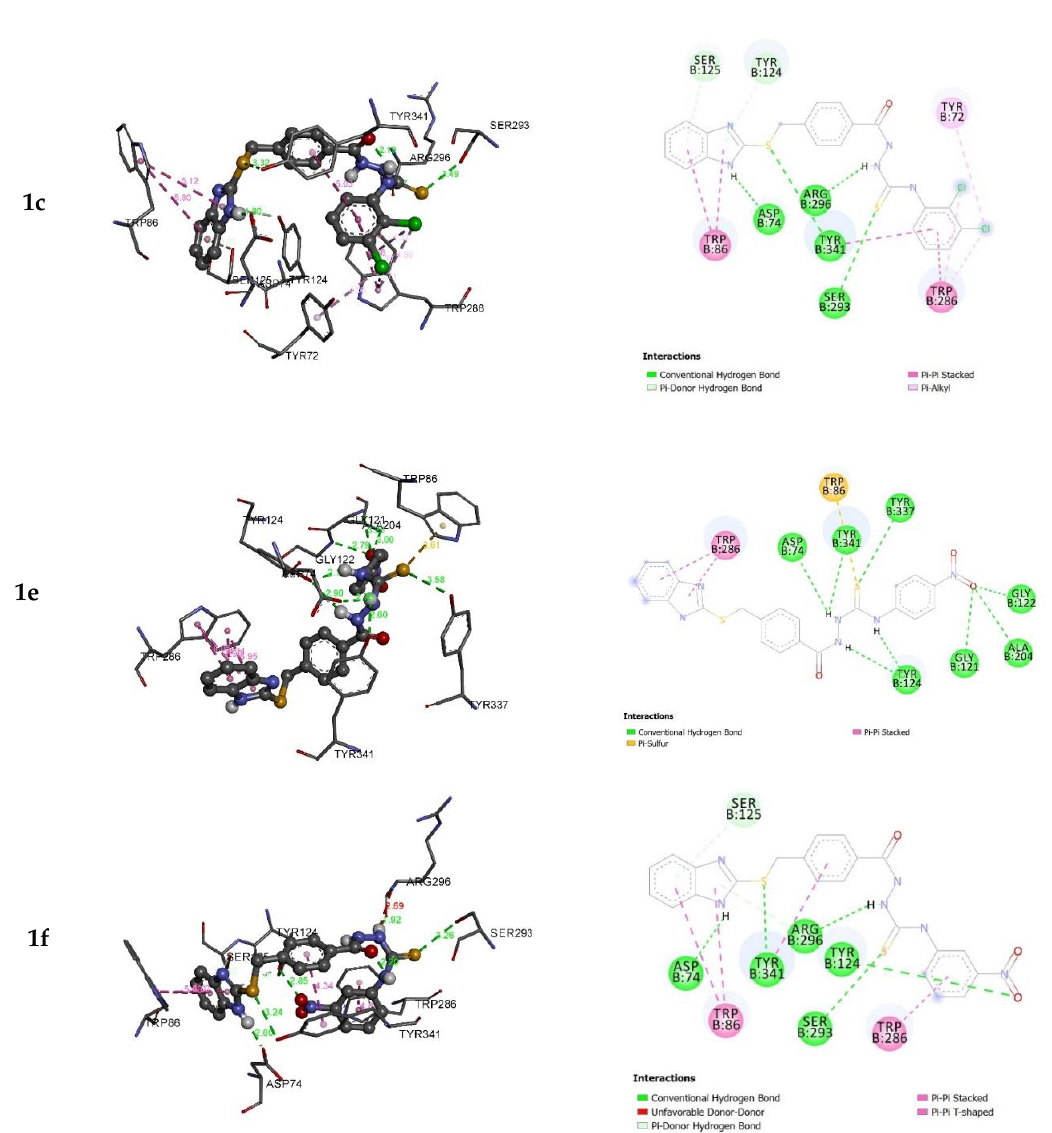
Figure 3. Three-dimensional ( right ) and two-dimensional ( left ) closest interactions between the active site residues of acetylcholinesterase and benzimidazole thiosemicarbazide derivatives 1c , 1f , and 1f .